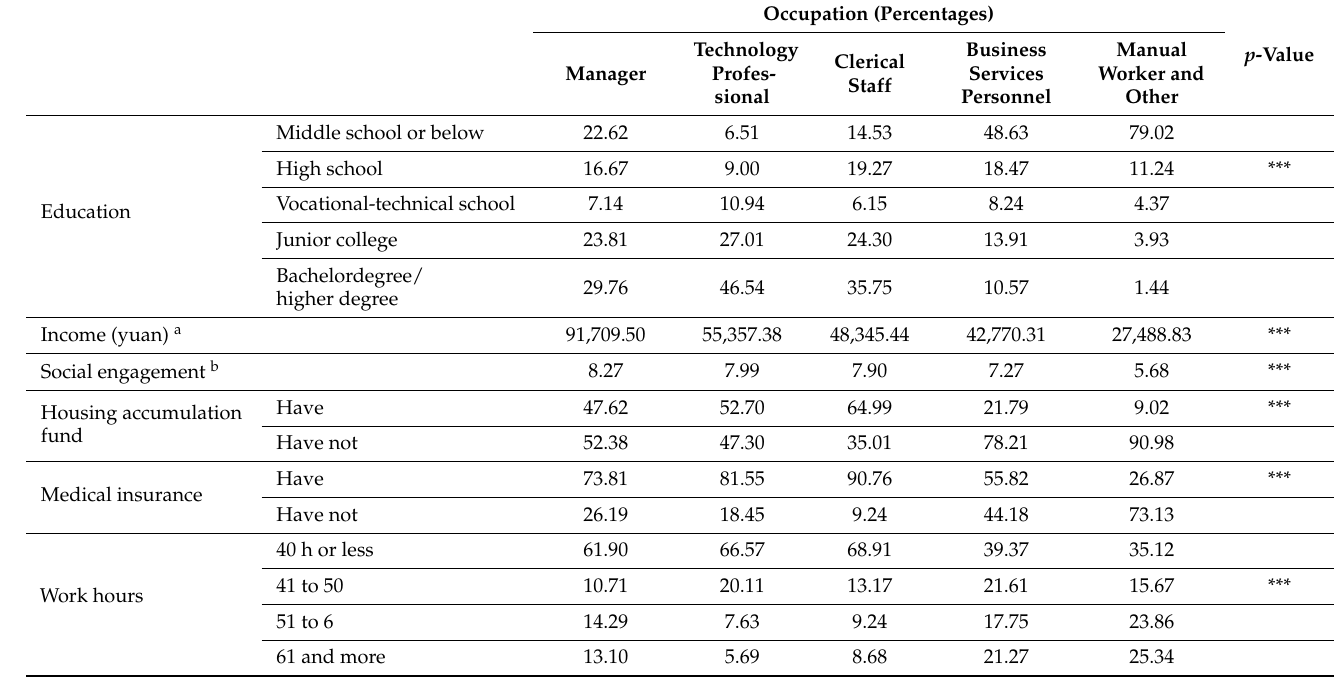
Table 3. Difference in education and welfare by occupation